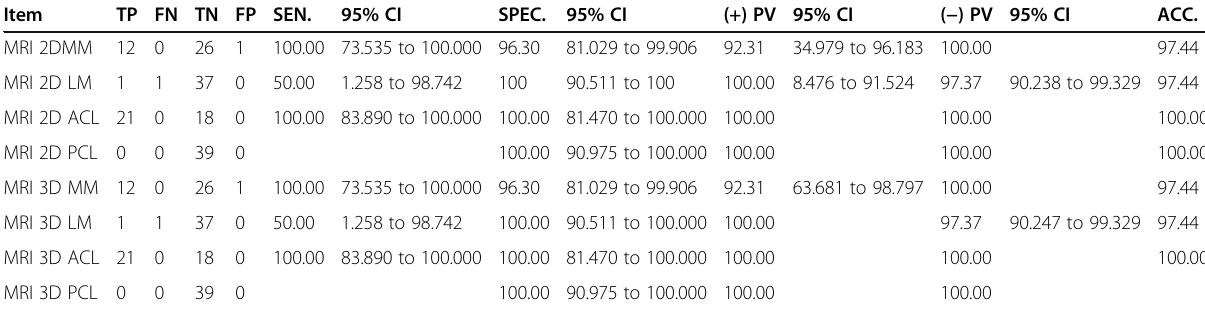
Table 2 Comparative study between protocol A and protocol B Item